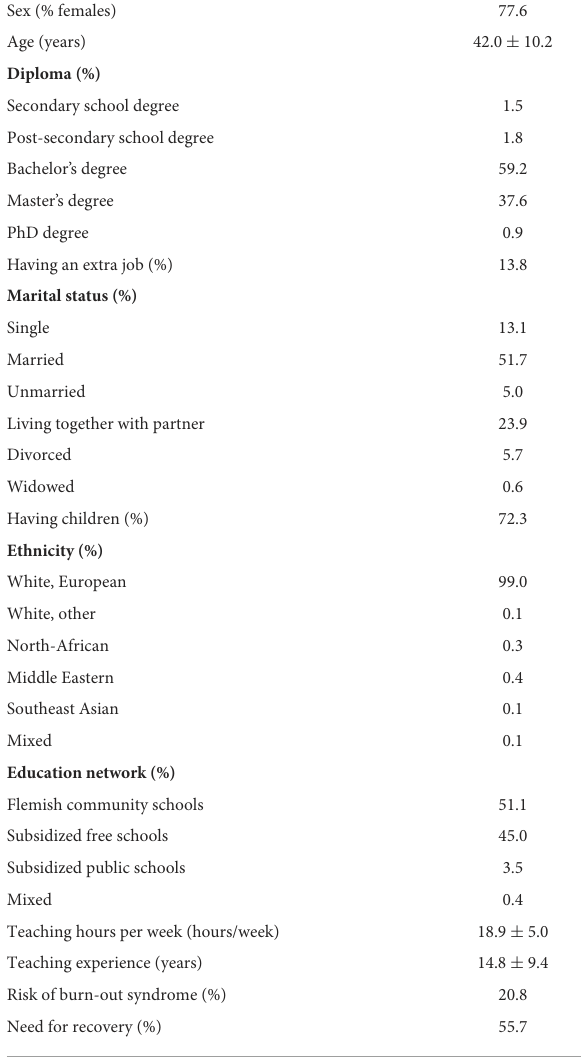
TABLE 1 Baseline sample characteristics (T0; n =